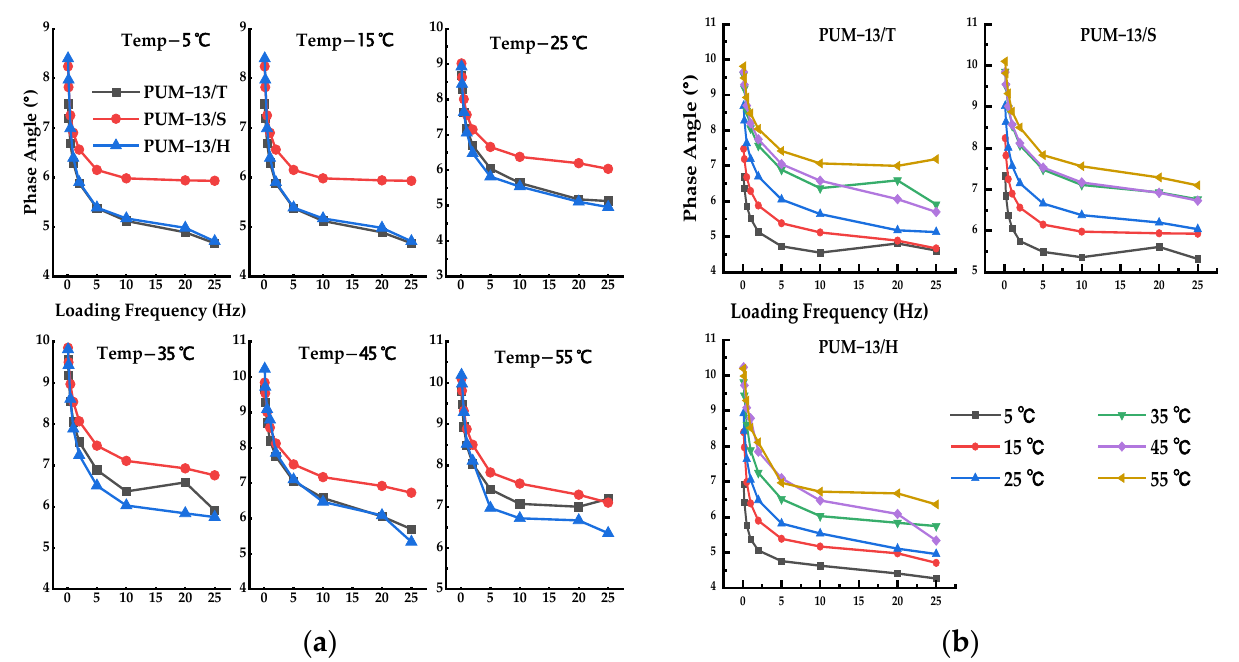
Figure 9. The phase angle of the PU mixtures with the same gradation and different PU types. ( a ) phase angle under different test temperatures, ( b ) phase angle with different PU types. 3.6. The Effect of the PU Content on the Dynamic Modulus and Phase Angle The dynamic modulus and phase angle results of the PU mixtures with the same gradation and different PU contents at different test temperatures and loading frequencies ae plotted in Figures 10 and 11.